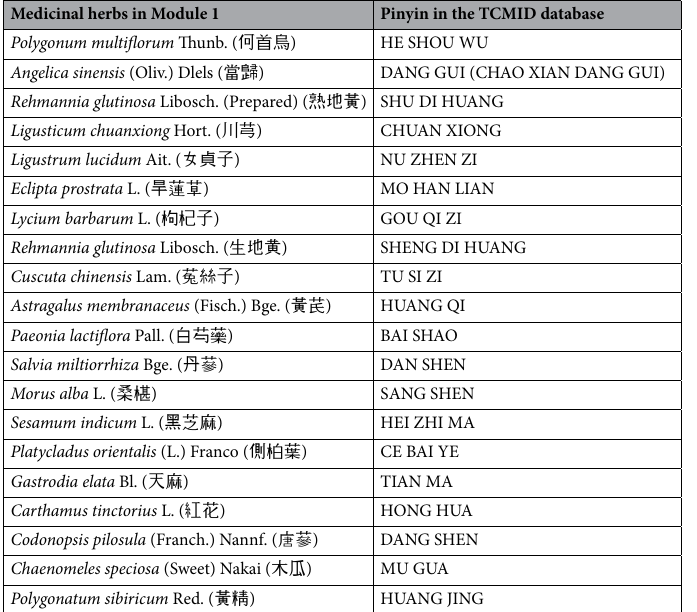
Table 1. List of the top 20 main medicinal herbs in Module 1 from a previous study. Related to the liver and kidney.